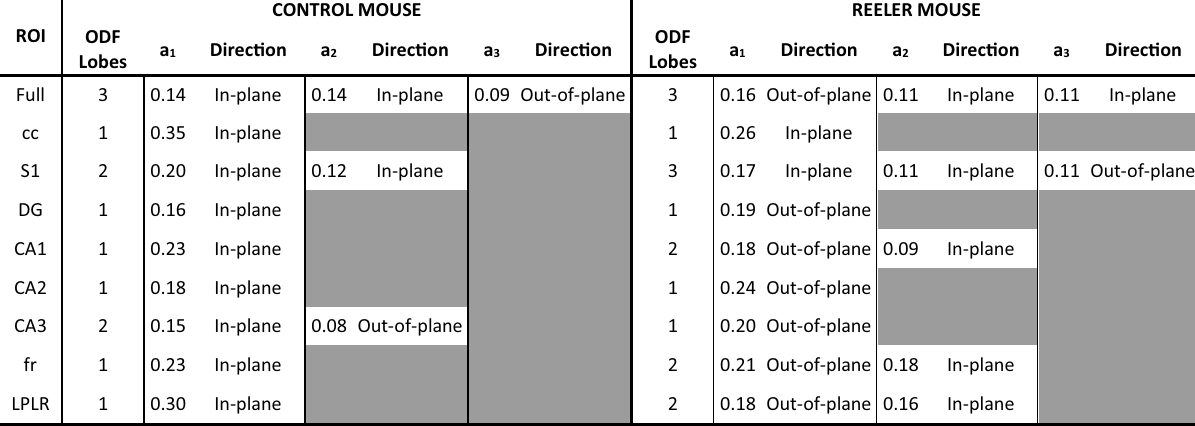
Table 1. ODF components analysis Amplitude (a1, a2, a3) and main orientation (direction) of the significant ODF components of both control and Reeler mouse hippocampi are shown. Table cell is gray if the peak amplitude is < 50% of the primary peak. Acronyms list = Full: full field of view; S1: Primary Somatosensory Cortex; cc: Corpus Callosum; CA1, CA2, CA3: field CA1, CA2, CA3 of hippocampus; DG: Dentate Gyrus; fr: Fasciculus Retroflexus; LPLR: Lateral Posterior Thalamic